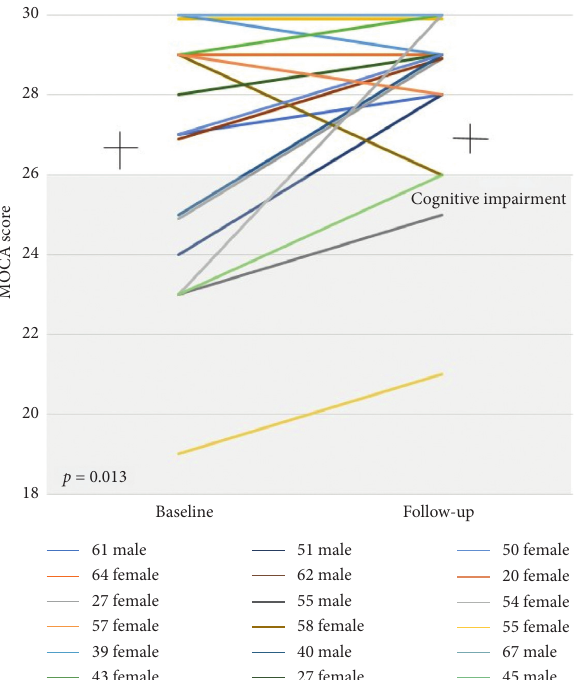
Figure 6: Changes in MOCA score pre-post